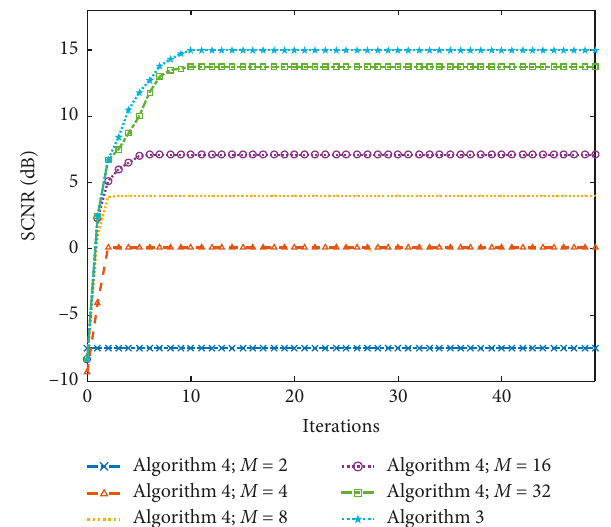
Figure 5: SCNR vs. number of iterations. Algorithm 4: phase quantized sequence. Algorithm 3: continuous phase